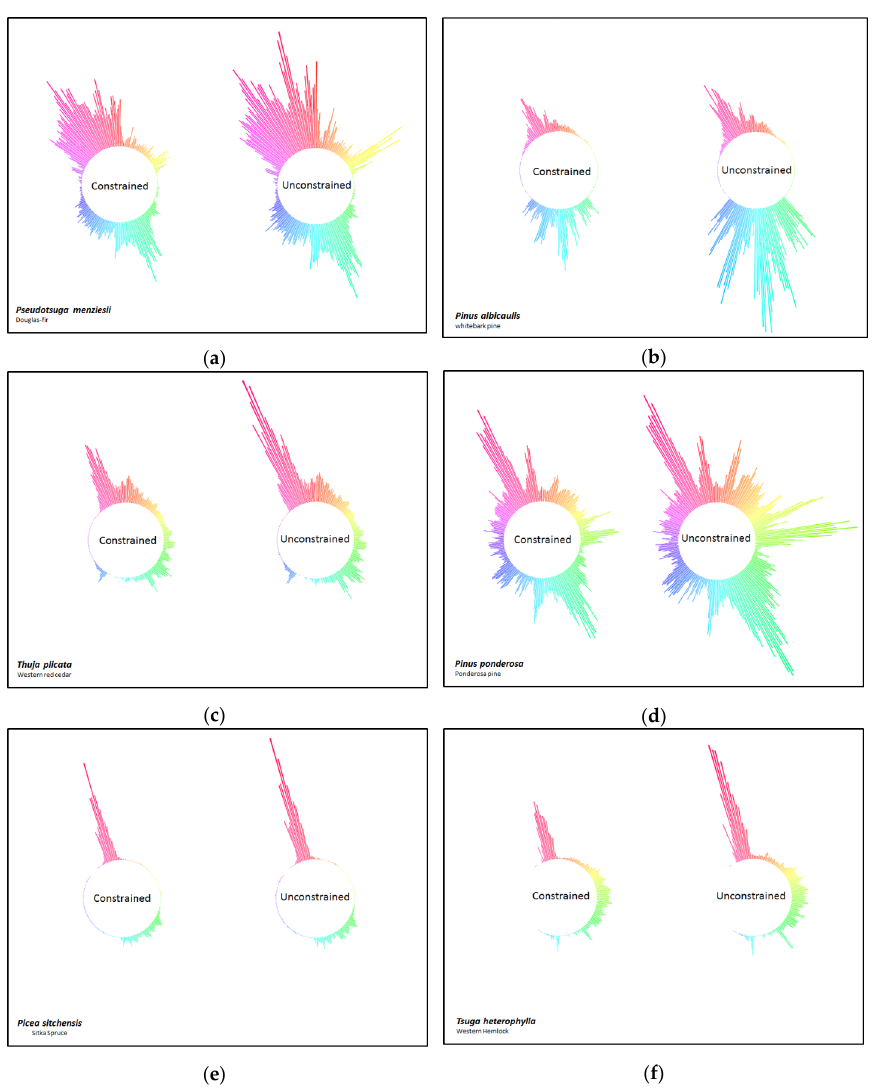
Figure 4. ( a – f ) Predicted direction and area (length of the ray) of potential migration by six tree species in response to expected shifts in climatic conditions by 2080. ( Left ) Migration constrained by realistic maximum rates (200 m/y) and landscape barriers; ( right ) migration constrained by realistic maximum rates (200 m/y), but unconstrained by landscape barriers.